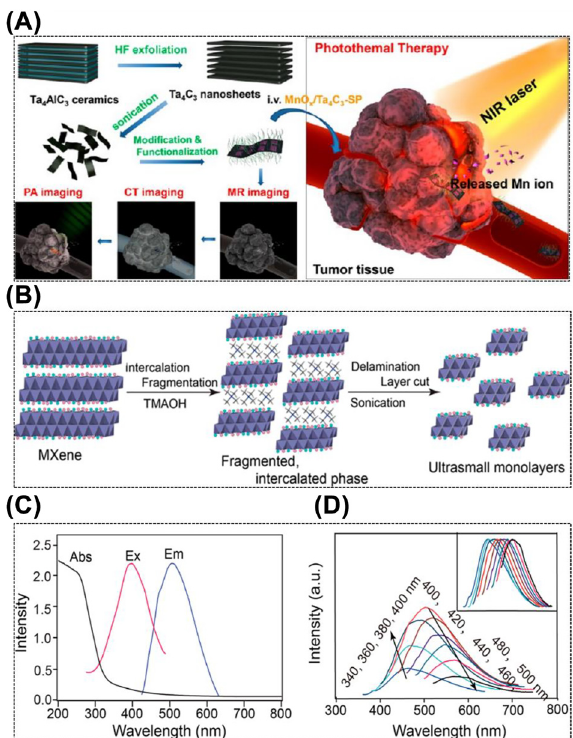
Figure 3: Photonic properties of MXene. (A) Schematic diagram of fabrication and surface modification process of MnOx/Ta PTT guided by PA/CT/MR tri-modal imaging [24]. Copyright 2017, American Chemical Society. (B) Schematic diagram of the synthesis process for the preparation of ultrathin Ti absorption, emission, and excitation spectra of Ti emission spectra at different excitation wavelengths from 340 to 500 nm. The inset in (D) shows the corresponding normalized emission spectra [28]. Copyright 2017, American Chemical